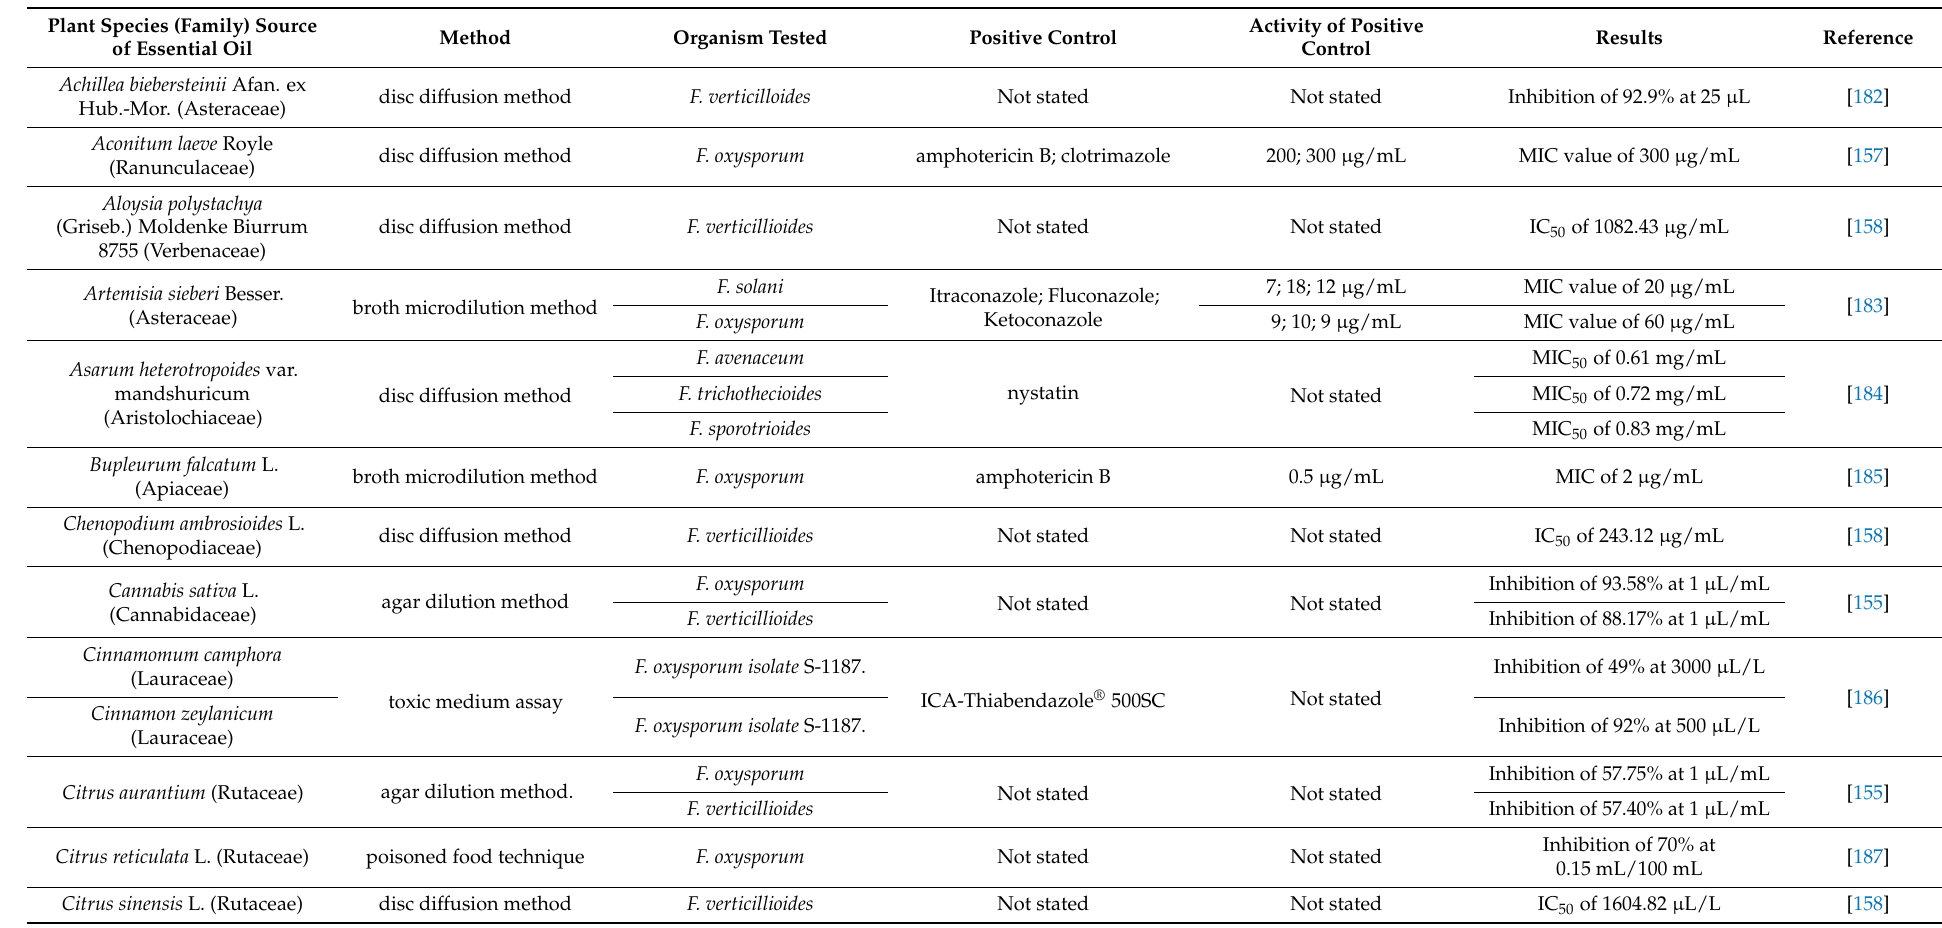
Table 3. Antifungal activity of essential oils obtained from plants used in traditional medicine. The oil samples were evaluated against Fusarium phytopathogenic species using different methods and their activities were reported as minimum inhibitory concentration, half-maximal inhibitory concentration (IC 50 ) or percentage inhibition